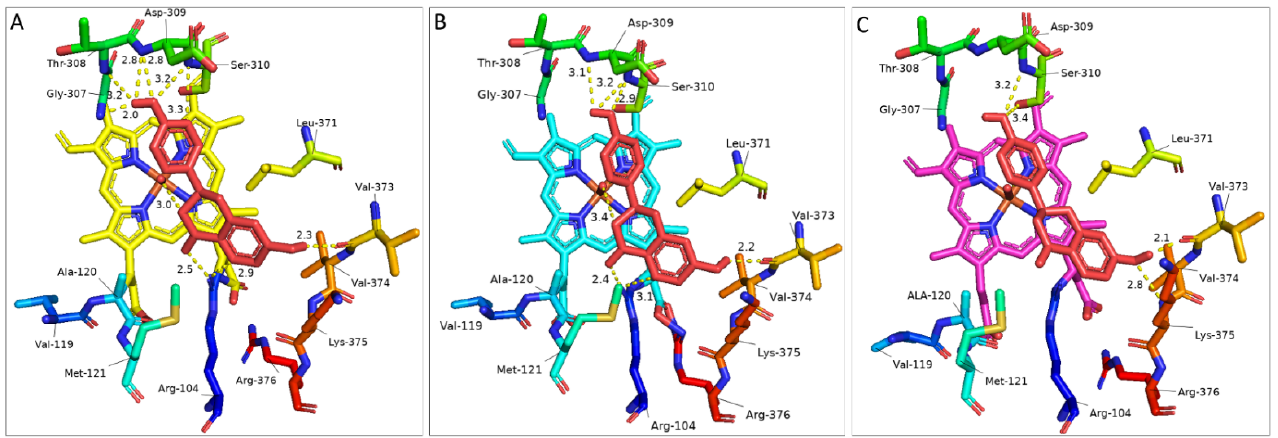
Table 2. Binding energy ( Δ G) comparison of selected IFS docked with LQN and NGN. Δ G for LQN Δ G for NGN Species